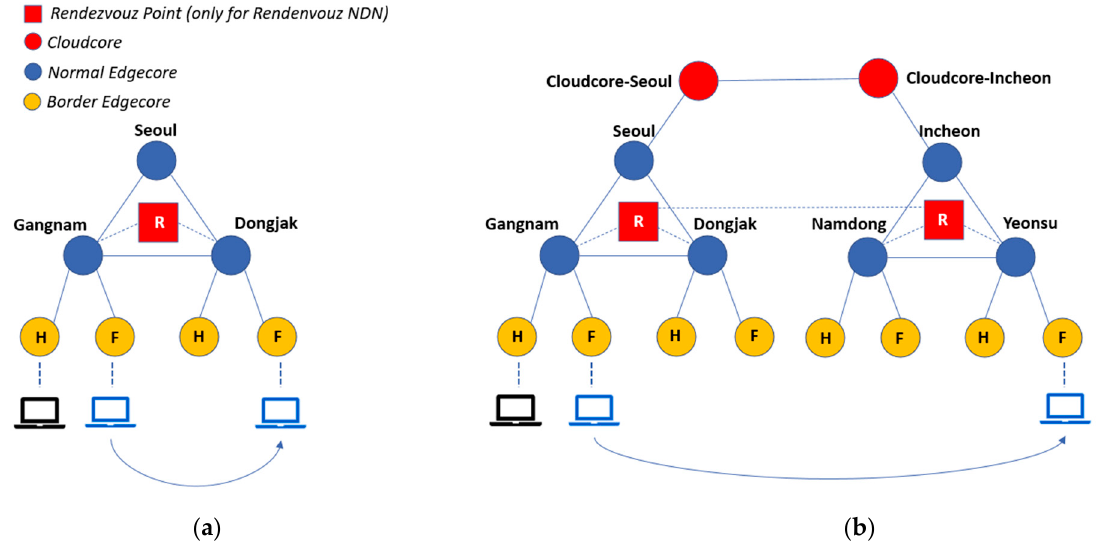
Figure 15. Network topologies and scenario for mobility handover measurement ( a ) Single region topology; ( b ) Cross- region topology.